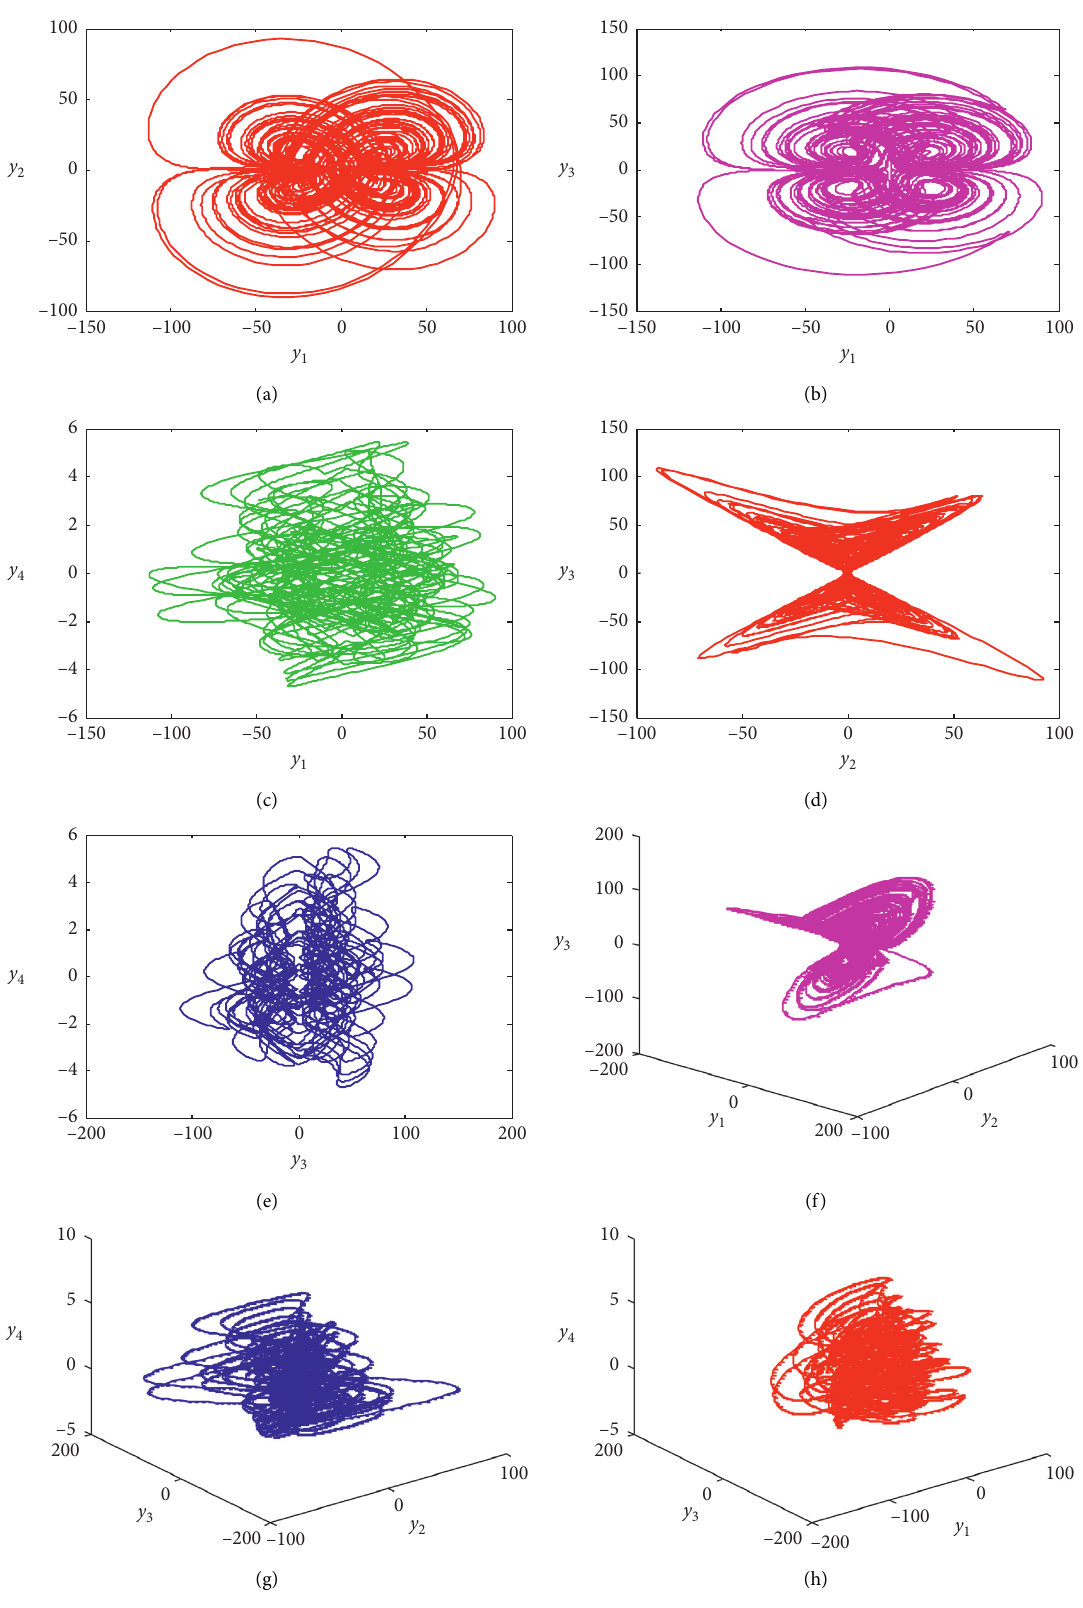
Figure 4: Phase portrait (3D) of the four-wing nonlinear hyperchaotic system when b y ( 0 ) � [ 10 , 1 , 10 , 1 ] T